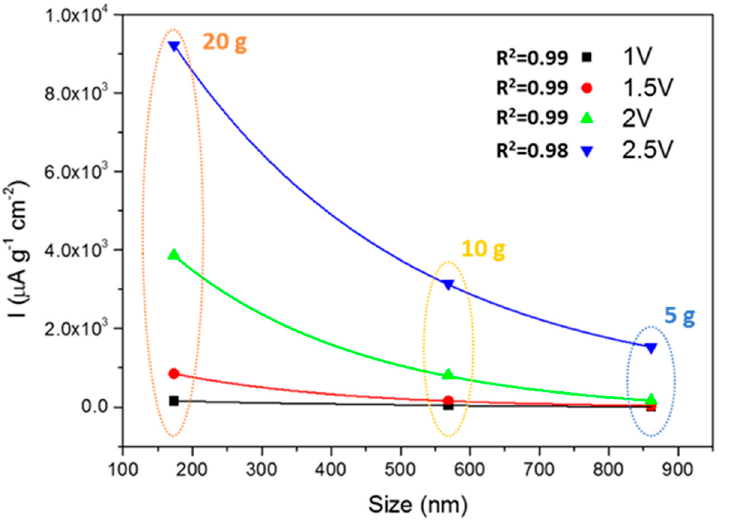
Figure 8. Dependence of the photocurrents from the material size for the materials obtained with PEG as a shape controller.